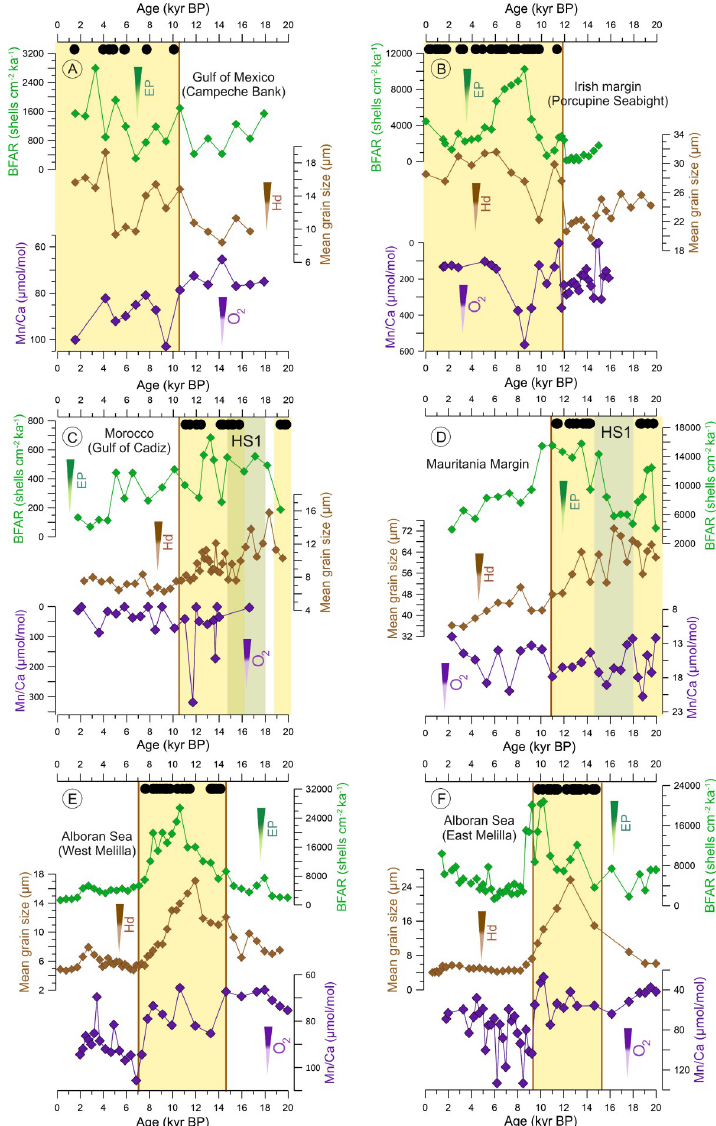
Fig 3. The long-term development of Lophelia pertusa in the North Atlantic and the Mediterranean Sea superimposed on food supply, bottom currents proxies, and bottom-water oxygenation during the last 20 kyr. The occurrence of L. pertusa in each region is indicated by black dots at the top, reflecting coral fragments dated by the U/Th and/or AMS 14 C method (see references in S2 Table), while the yellow vertical bars highlight periods of L . pertusa prolific phase with their limits defining on- and offsets of coral growth (vertical brown lines). The BFAR (green) is used to reconstruct the organic matter supply to the seafloor [74], while the mean grain size (brown) is used as a proxy for the bottom-water Hd [44,75]. The bottom-water oxygenation (O 2 ) was estimated qualitatively by the benthic foraminifera Mn/Ca ratio (note the inverse axis) following [71]. The greenish bar indicates the period of HS1, which (partly) overlaps with periods without coral growth off Mauritania and Morocco. The brown vertical line indicates the transition between on and offset of CWC proliferation. The underlying data for this figure can be found in https://doi. org/10.1594/PANGAEA.932775. BFAR, benthic foraminifera accumulation rate; BP, before present; EP, export production; Hd, hydrodynamics; HS1, Heinrich Stadial 1; O 2 , Oxygen.